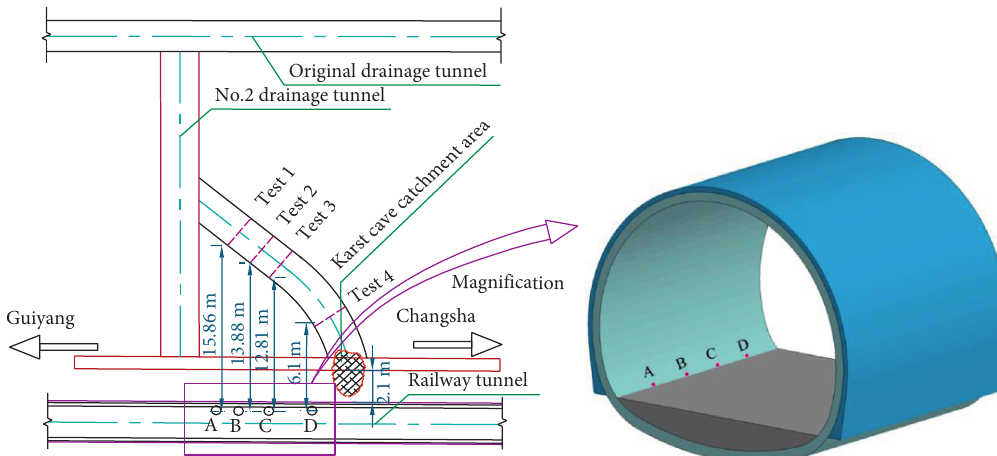
Figure 8: Relationship between explosion site and location of measuring points.